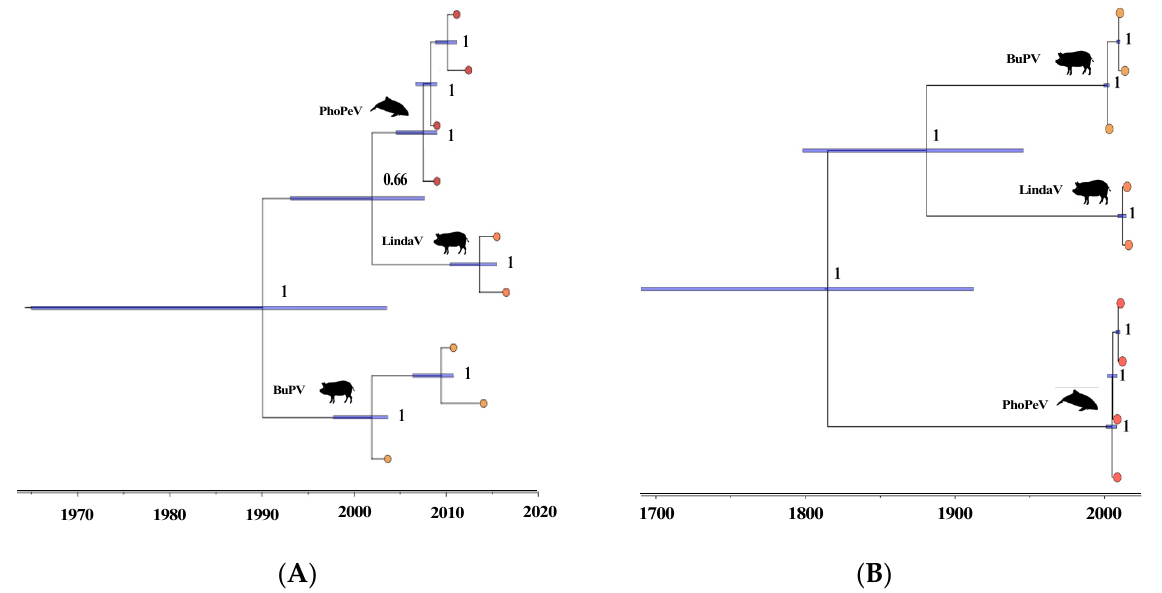
Figure 3. Time-calibrated Bayesian phylogenetic trees of available PhoPeV, Bungowannah pestivirus (BuPV) and Linda virus (LindaV) sequences (Supplementary Table S3) covering conserved regions 2 and 3 corresponding to the amino acid positions 1547–2321 and 2397–2688 numbered according to the reference sequence for BVDV-1 (strain SD-1) (accession number: M96751) [3]. The trees were generated in BEAST 2.5.2 under two different model setups. ( A ) Tree generated using a relaxed clock lognormal and an exponential coalescence tree prior. This tree was the most strongly supported tree based on the path sampling analysis (Supplementary Table S8). ( B ) Tree generated using a strict clock and a Bayesian skyline tree prior. This model set up showed the strongest support among models using a strict clock (Supplementary Table S8). The node bars represent the highest posterior density (HPD) interval of the time estimates, while the tree support is shown as posterior values at each